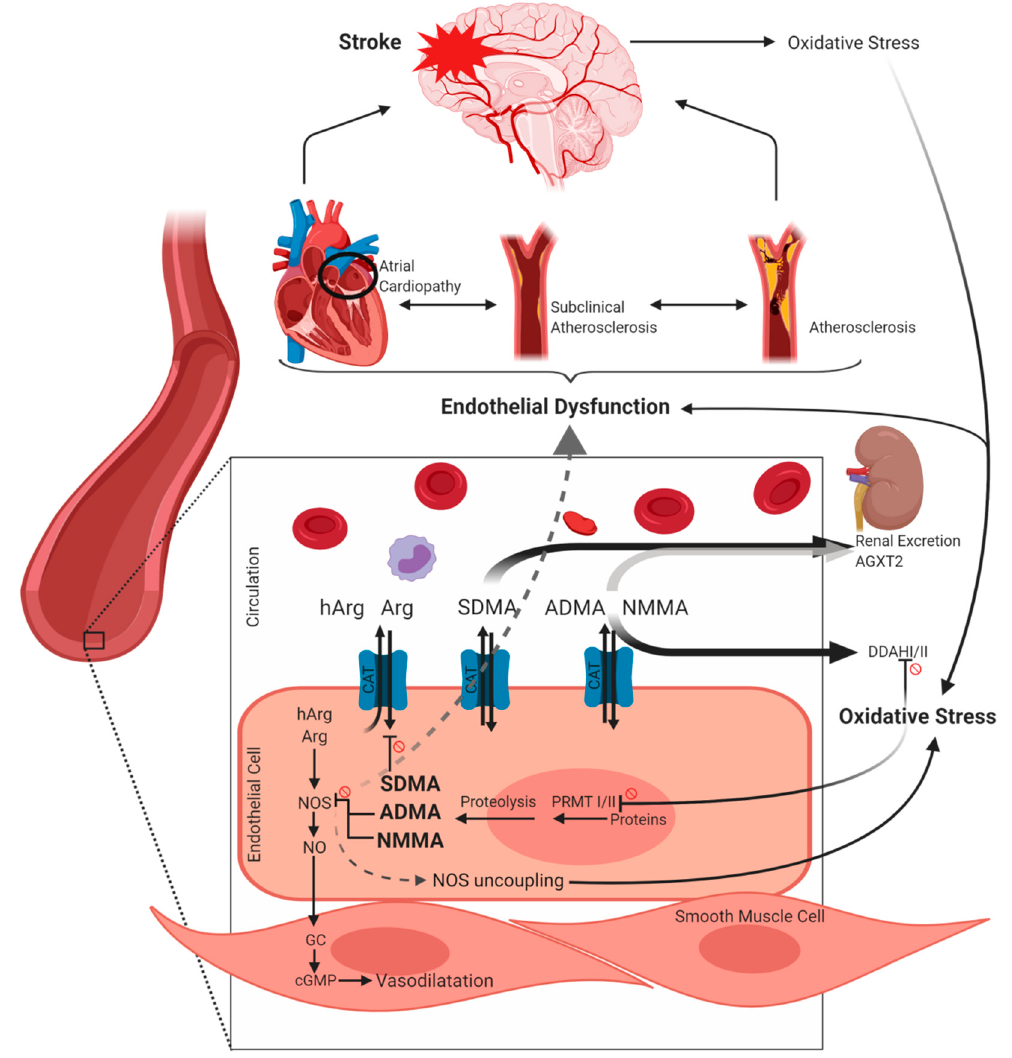
Figure 1. Overview on metabolism of arginine (Arg), homoarginine (hArg), asymmetric dimethylarginine (ADMA), symmetric dimethylarginine (SDMA) and monomethylarginine (NMMA)